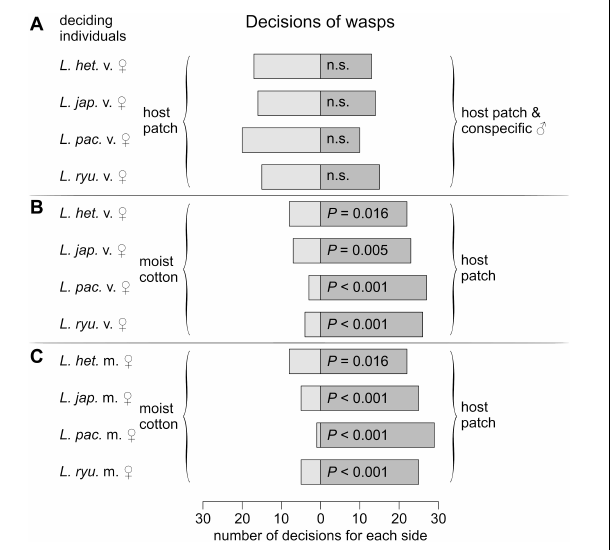
FIGURE 6 | Frequency of decision for control (light gray bars) or sample (dark gray bars) of males of L. heterotoma , L. japonica , L. pacifica , or L. ryukyuensis in a Y-tube experiment with a choice between the odor of unexploited host patches or host patches with either (A) 20 conspecific females or (B) extracts of their females; (C) Decisions of males of L. heterotoma , L. japonica , L. pacifica , or L. ryukyuensis for host patches or clean humidified air. P -values are given for two-sided binomial tests. For each experiment, N = 30. L. het. = Leptopilina heterotoma , L. jap. = Leptopilina japonica , L. pac. = Leptopilina pacifica , L. ryu. = Leptopilina ryukyuensis , v. = virgin, mc = moist cotton, n.s. = not significant.